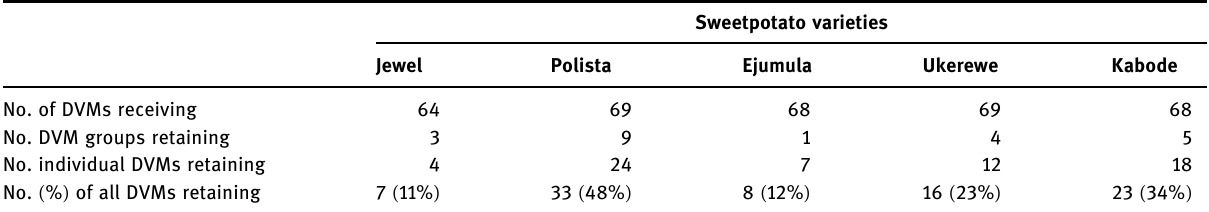
Table 4: Number and percentage of group and individual DVMs who retained planting material of Marando Bora distributed sweetpotato varieties, Lake Zone, Tanzania, 2016 –